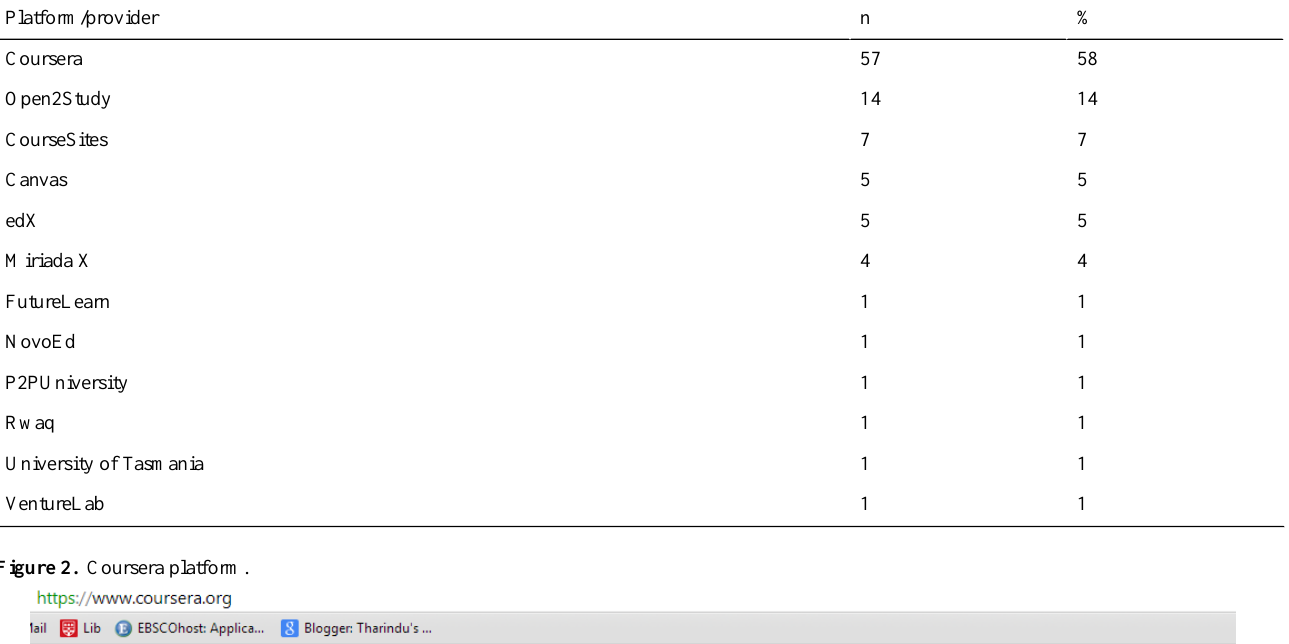
Table 2. MOOCs by platform/provider (n=98).